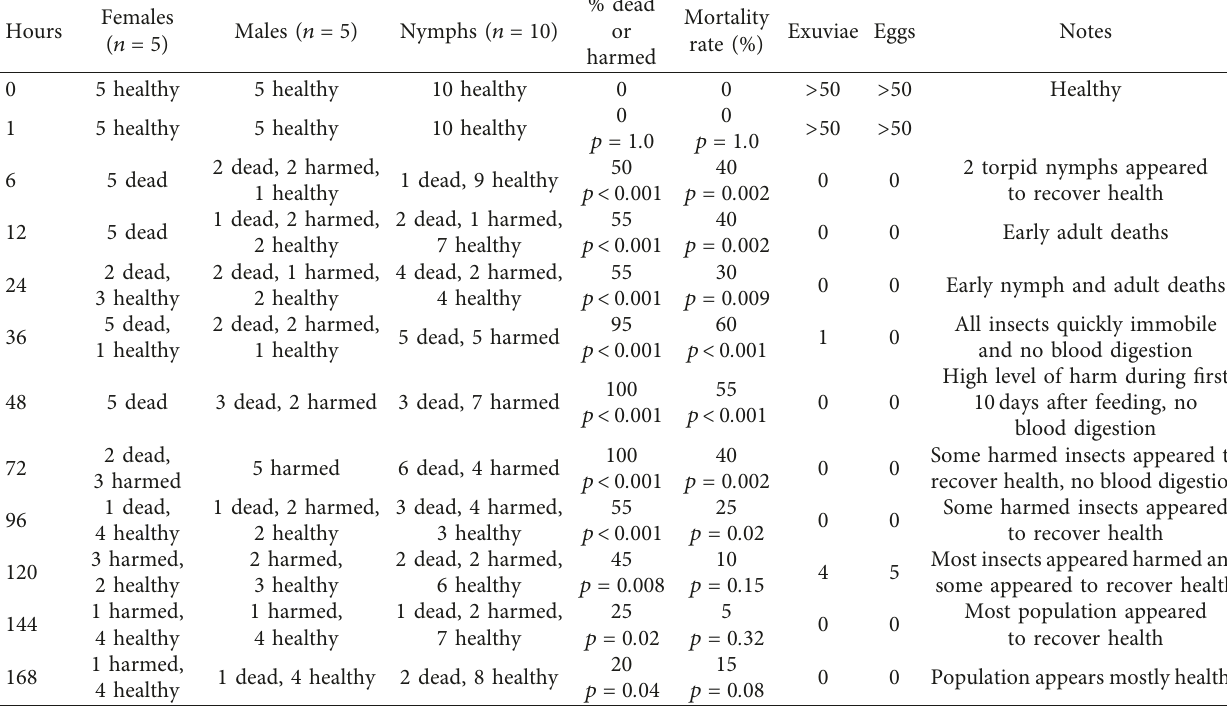
Table 1: Test 1 data with incapacitation rate for each life stage, exuviae, and eggs at day 45 for each group fed at different hours after ivermectin injection.